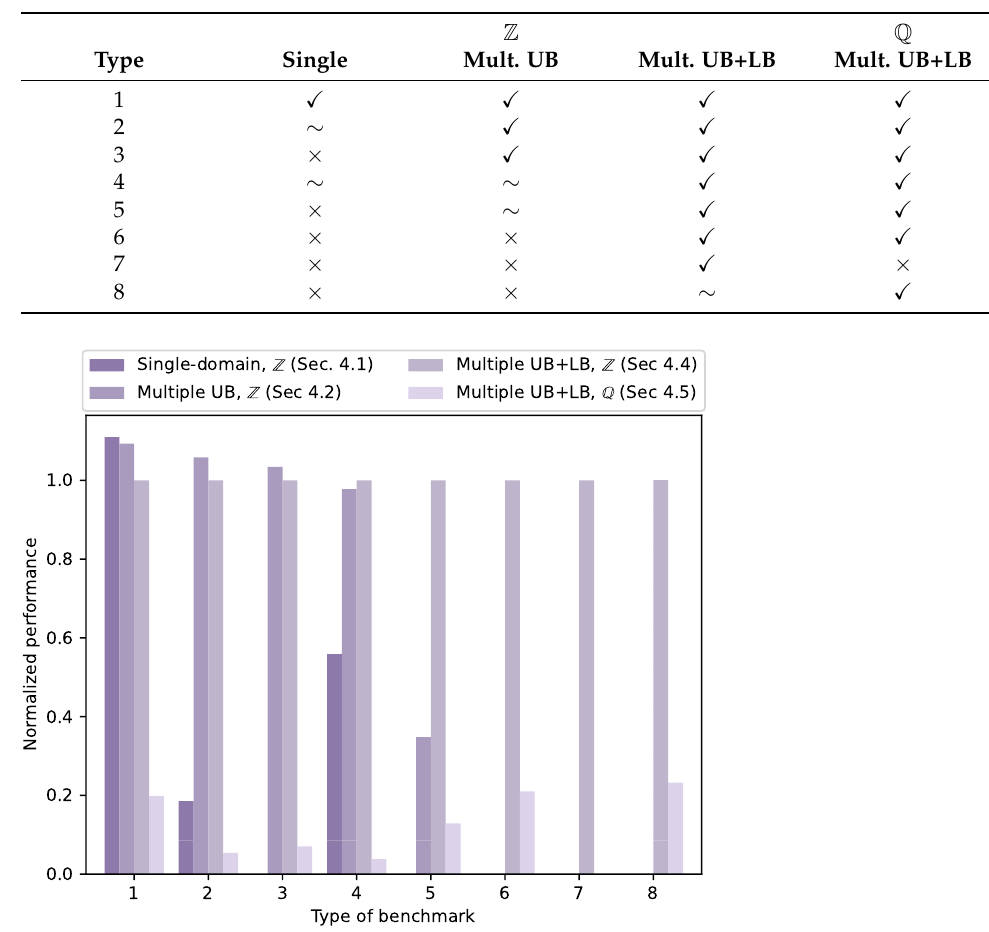
Figure 10. Reconstruction performance grouping benchmarks by type as shown in Table 2. Results are normalized to the performance of the approach using multiple upper and lower bounds over Z presented in Section 4.4. Hatched bars indicate suboptimal